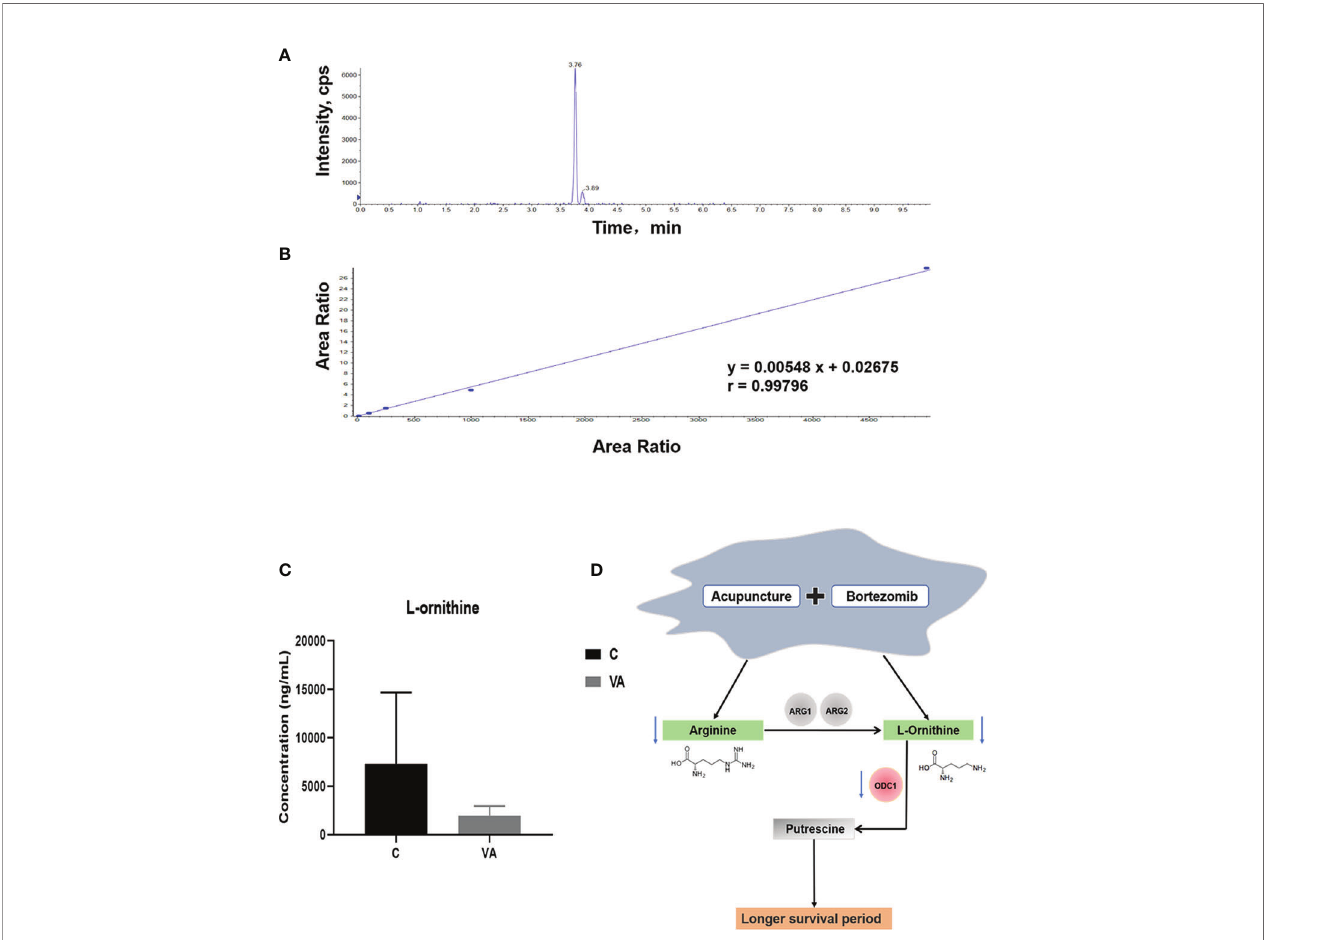
FIGURE 6 | Ornithine concentration is decreased in serum samples of group VA. (A) Characteristic chromatographic peak of ornithine standard. (B) Standard curve of ornithine in targeted metabolomics. (C) Ornithine concentration in serum samples of group C and VA. (D) The possible mechanism involved in VA